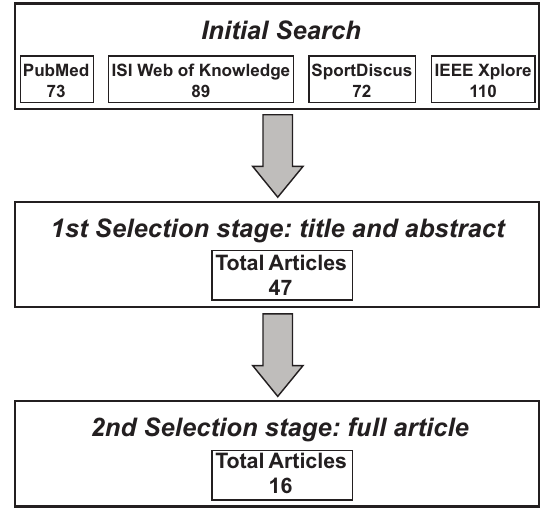
Figure 2. Article review procedures. After the initial search, the title and abstract were reviewed first to exclude unrelated articles. The full articles were then retrieved and reviewed with the detailed inclusion/exclusion criteria. 16 articles were finally included in this review. Initial Search PubMed ISI Web of Knowledge SportDiscus 73 89